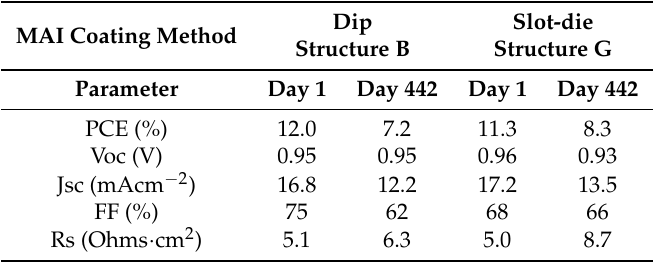
Table 4. Shelf-life stability of devices stored for 442 days, with slot-die coated lead iodide coated on heated substrates with either dip or slot-die coated MAI. Results are the mean of reverse direction light scans of devices, one device with three pixels was tested for each split, for the dip coated devices data for only one pixel is shown as the silver paste contacts to the other pixels had flaked away and good contact to the pixels could not be